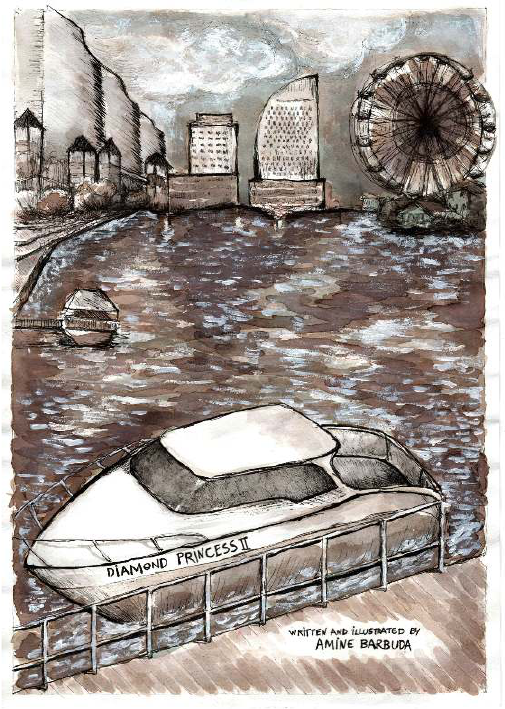
Figure 2: Plate 1, Diamond Princess II